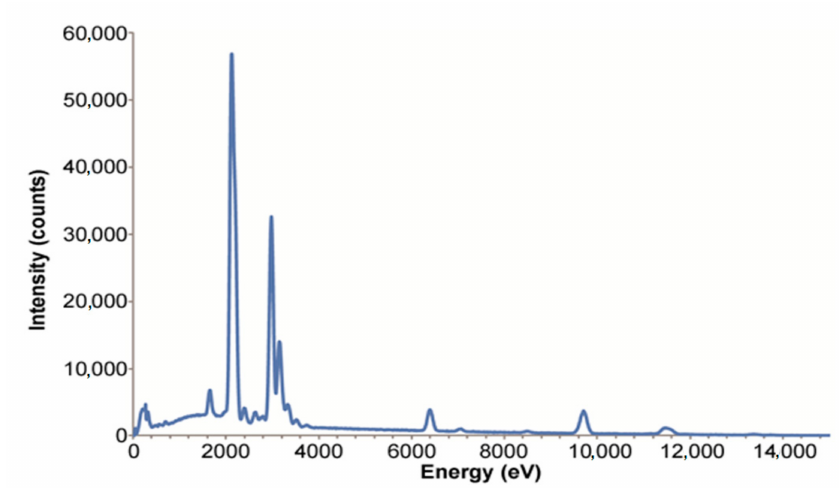
Figure 3. EDX test result.